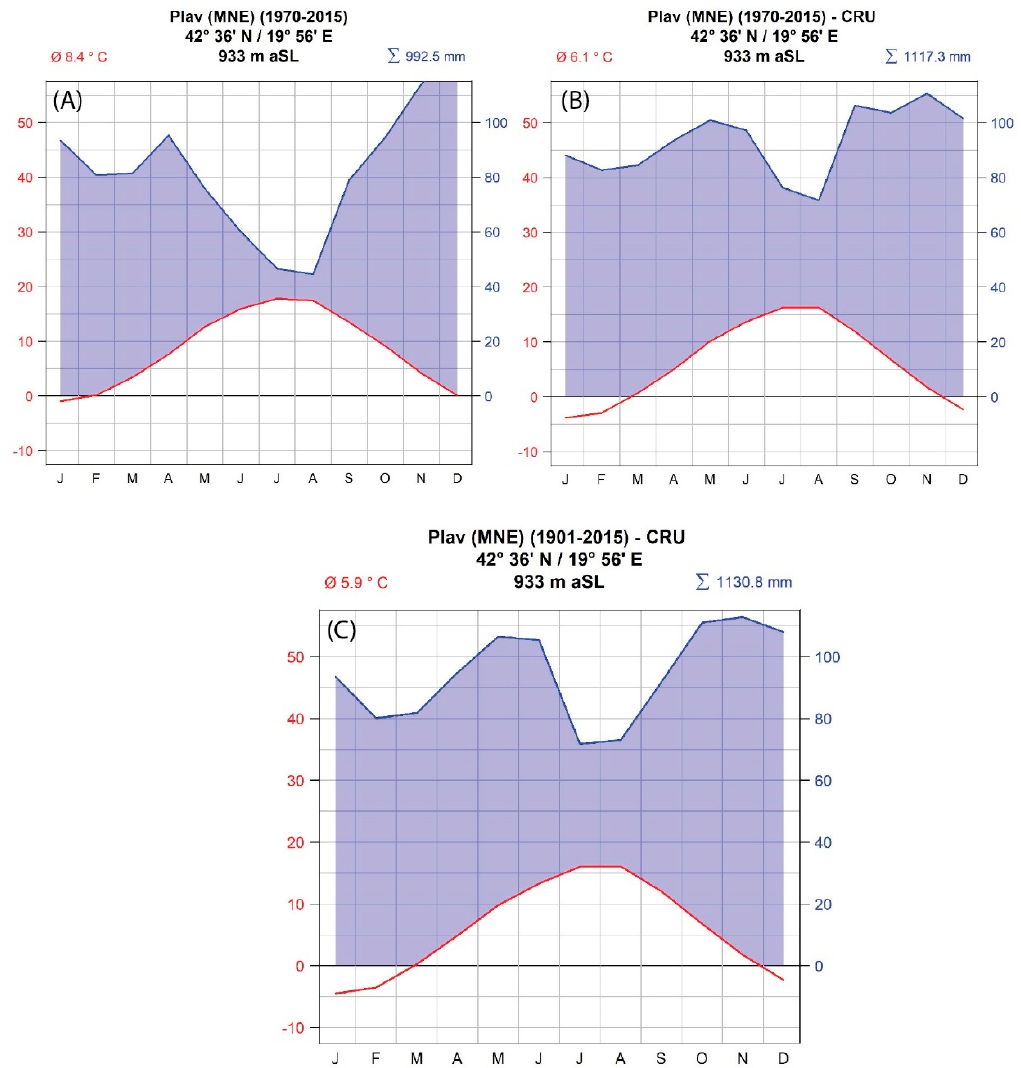
Figure 2. Climate diagrams for the city of Plav (Montenegro) based on ( A ) data from the local meteorological station and ( B ) data from the CRU TS 3.24 gridded climate data for the period 1970–2015 (for comparison) and ( C ) for the entire period of gridded climate data—1901–2015.